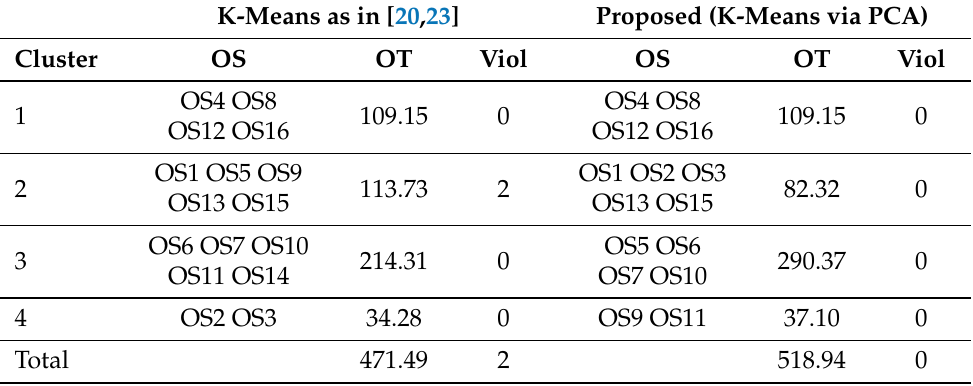
Table 8. Comparison of results using K-means and PCA technique.